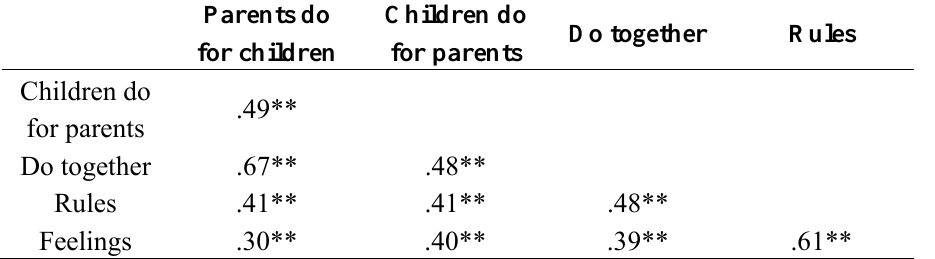
Table 1. Correlations of five areas of PCRSS (Parent-Child Relationship Schema Scale) with each other (Overall probability with 10 df p < 0.0001).